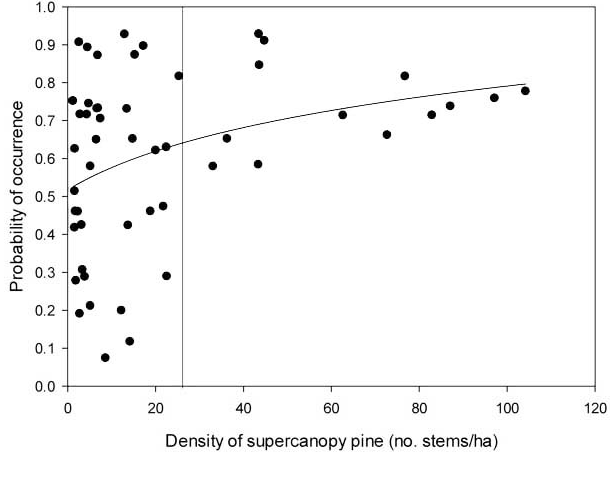
Fig. 8 . Relationship between the density of supercanopy pine trees and the probability of occurrence of Black- throated Green Warbler in pine forests. Threshold derived from ROC curve is shown as vertical line (see